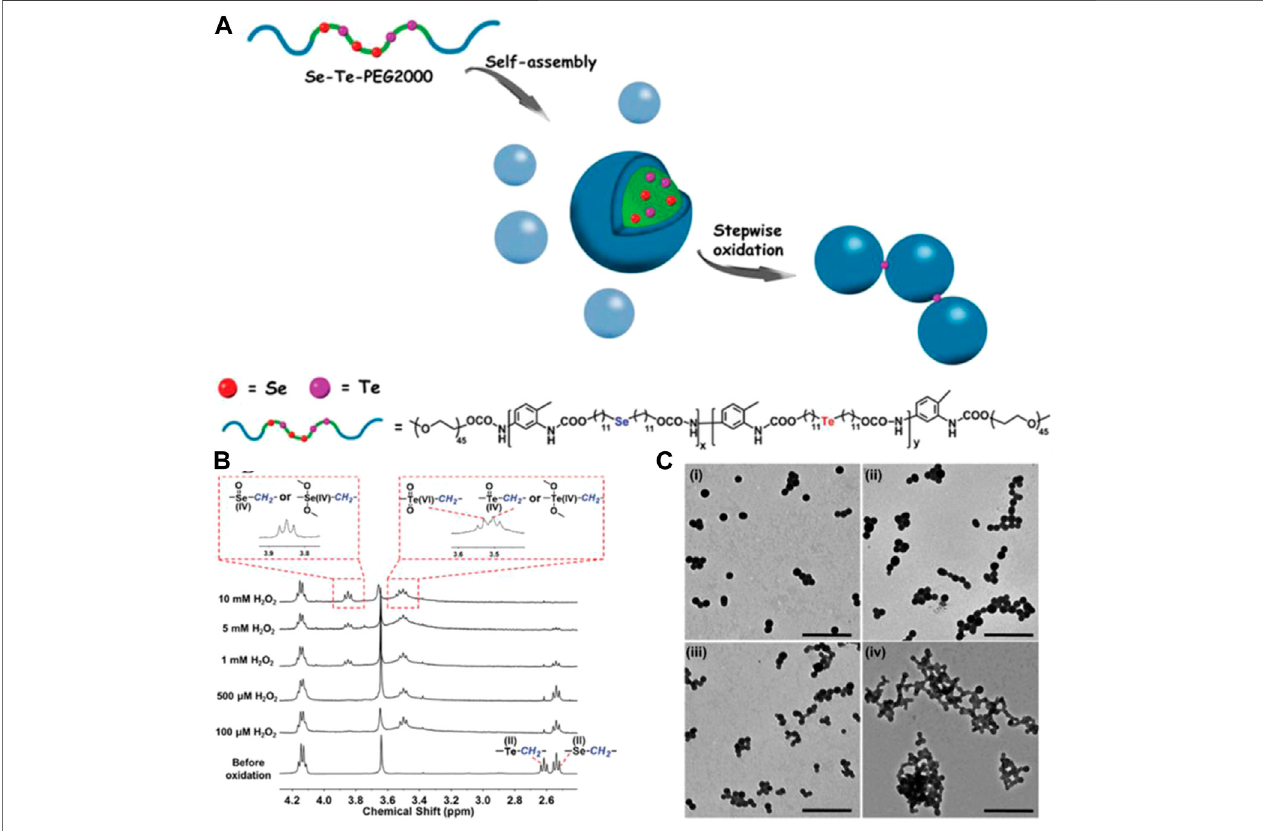
FIGURE 10 | (A) Schematic illustration of Se – Te – PEG2000 mechanism of stepwise oxidized activity and chemical structure. (B) 1H NMR spectra of Se – Te – PEG2000 before and after oxidation for 5 h when exposed to different concentrations of H 2 O 2 . (C) TEM images of Se – Te – PEG2000 after oxidation by 10 mM H 2 O 2 for different oxidation periods: (i) 5 h, (ii) 12 h, (iii) 24 h, and (iv) 72 h (Wang et al., 2017). Copyright 2017, the Royal Society of